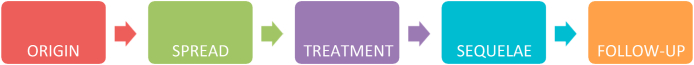
Flow chart of sequence of events in a viral disease and its management.